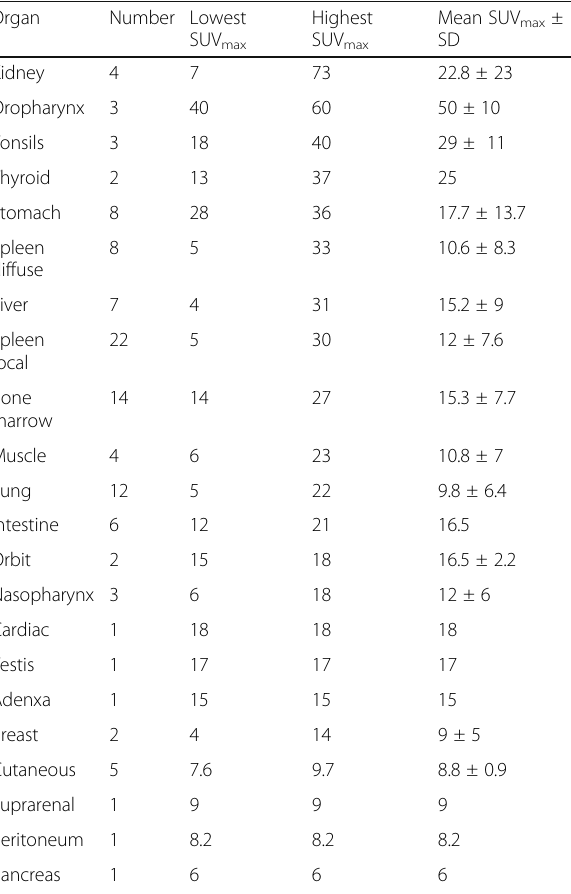
Table 2 Relation between SUV and sites of extranodal involvement (listed according to SUV